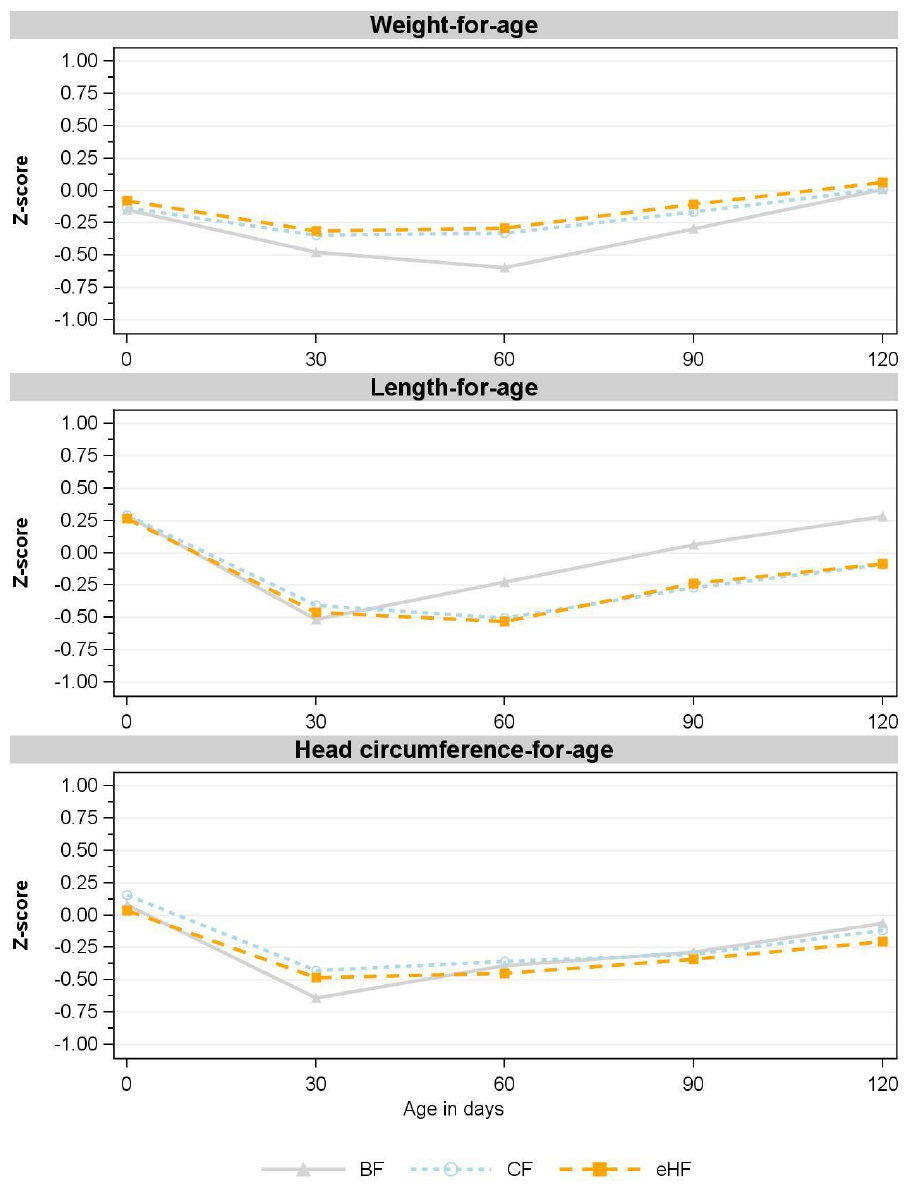
Figure 3. Observed mean for weight-for-age, length-for-age and head circumference-for-age z-scores between birth and 180 days of age (V5) (FAS) . V1: 30 days; V2: 60 days; V3: 90 days; V4: 120 days; V5: 180 days. Missing values in CF: weight-for-age: V1: n = 1; V3: n = 3; V4, V5: n = 2; length-for-age: V1, V3: n = 1, V4, V5: n = 2; head circumference-for-age: V1: n = 1, V3, V4, V5: n = 2.